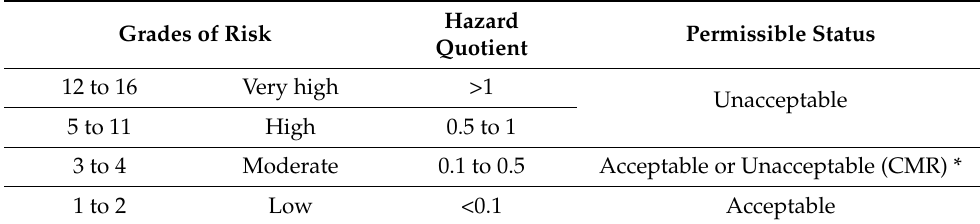
Table 2. Classification of risk assessment level. Hazard Permissible Status Grades of Risk Quotient 12 to 16 Very high >1 Unacceptable 5 to 11 High 0.5 to 1 3 to 4 Moderate 0.1 to 0.5 Acceptable or Unacceptable (CMR) * 1 to 2 Low <0.1